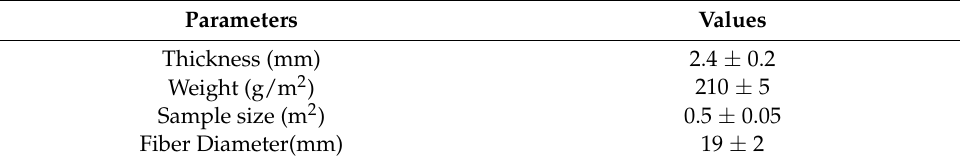
Table 1. Needle punched nonwoven sample specification.